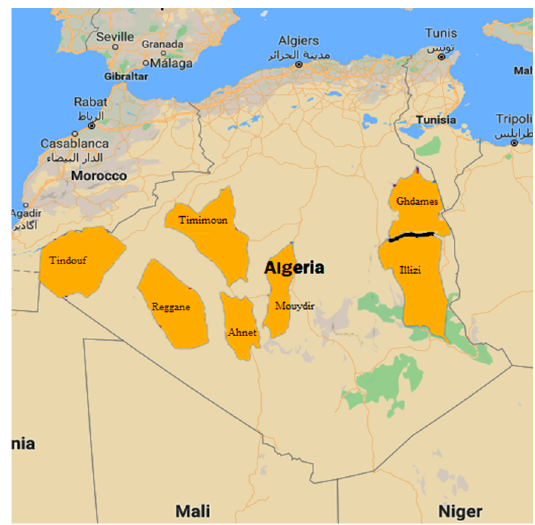
Figure 4. The location of gas and oil basins in Algeria.